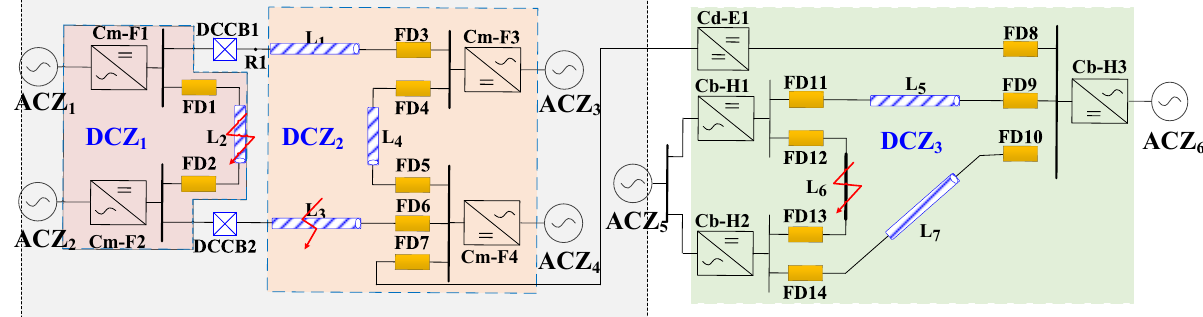
Figure 8. Topology structure of seven ‐ terminal DC network. Table 2. Parameters of converter stations.